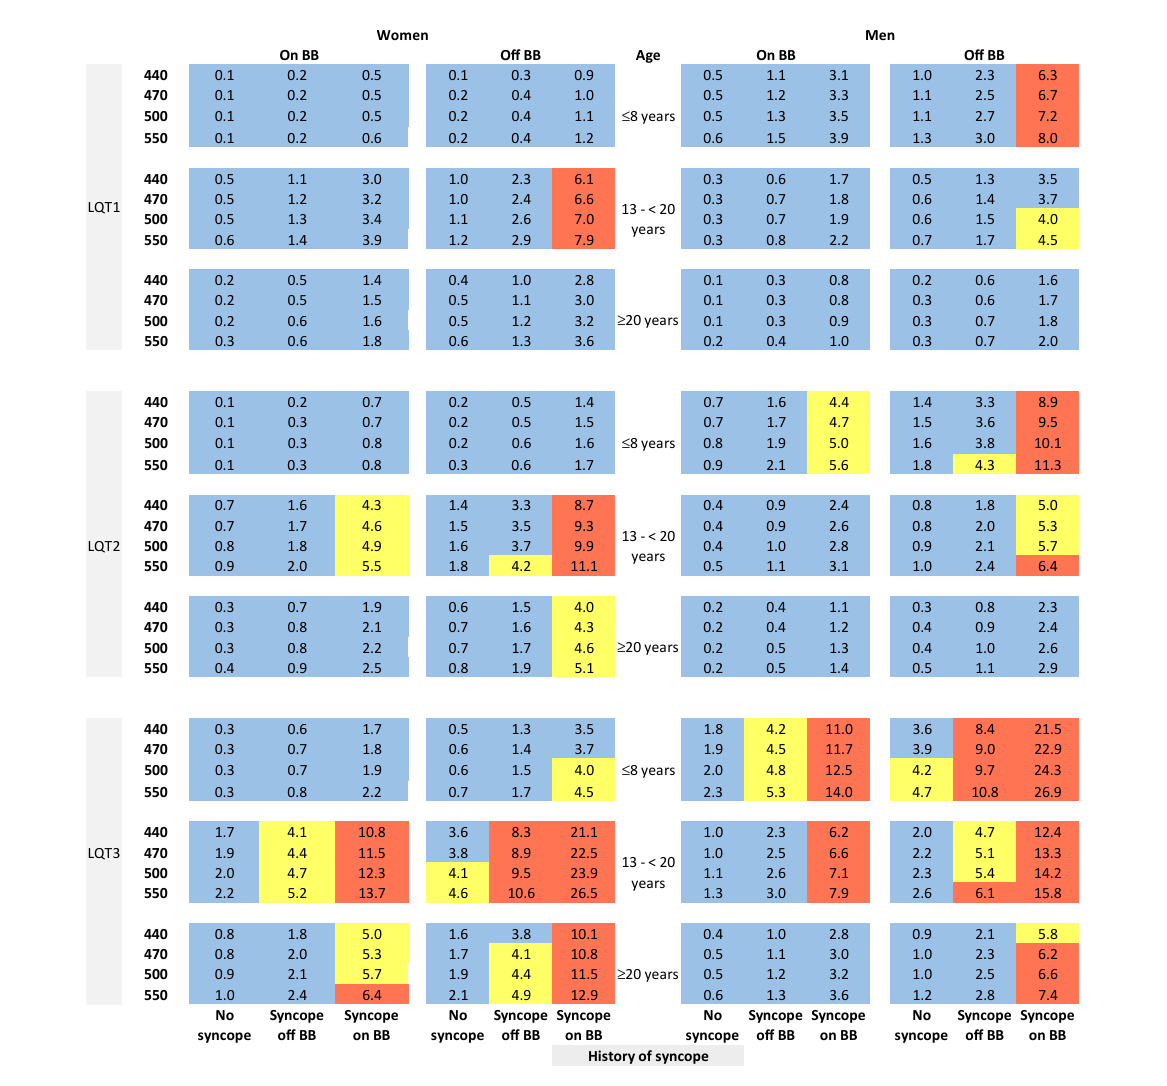
FIGURE2 Predicted 5-year risk of life-threatening arrhythmic events (aborted cardiac arrest, sudden cardiac death, or appropriate ICD shocks) for some example risk factor combinations for patients with a single mutation in LQT1, LQT2, or LQT3. Blue color indicates a predicted 5-year risk of < 4%, yellow color indicates a predicted 5-year risk of 4% to < 6%, and red color indicates a predicted 5-year risk of ≥ 6%. Numbers in this figure are percentage. BB,